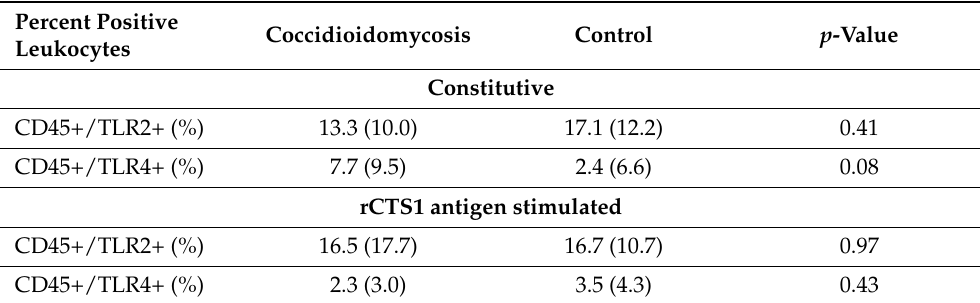
Table 5. Comparison of constitutive and rCTS1 antigen-stimulated leukocyte expression of toll- like receptor (TLR)-2 and TLR4 in 22 dogs with coccidioidomycosis and 10 healthy controls. Data presented as mean and standard